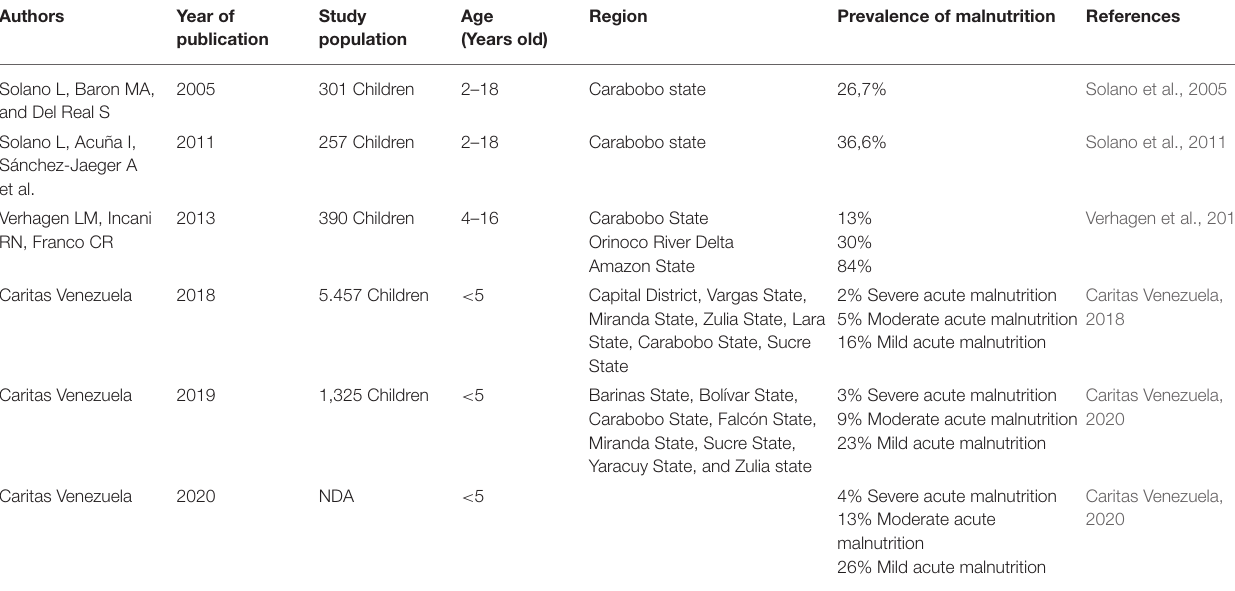
TABLE 1 | Malnutrition prevalence studies in Venezuela between 2005 and